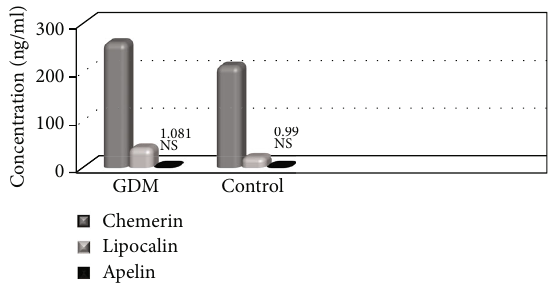
Figure 2: Chemerin, lipocalin 2, and apelin in GDM and control (Table 3). No correlation between apelin and BMI was observed.